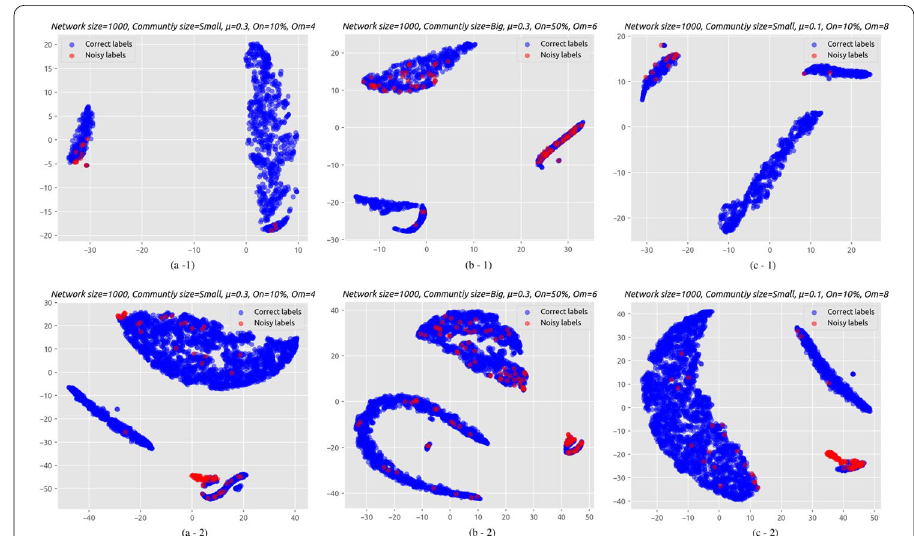
Fig. 2 An illustration of the differences between the distributions of must-link and cannot-link constraints, as viewed in a low-dimensional space, for a sample of small networks. The plots in the first row (a-1, b-1, c-1) show the must-link constraints of a sample set of small synthetic networks. The second row (a-2, b-2, c-2) shows the cannot-link constraints of the same set of